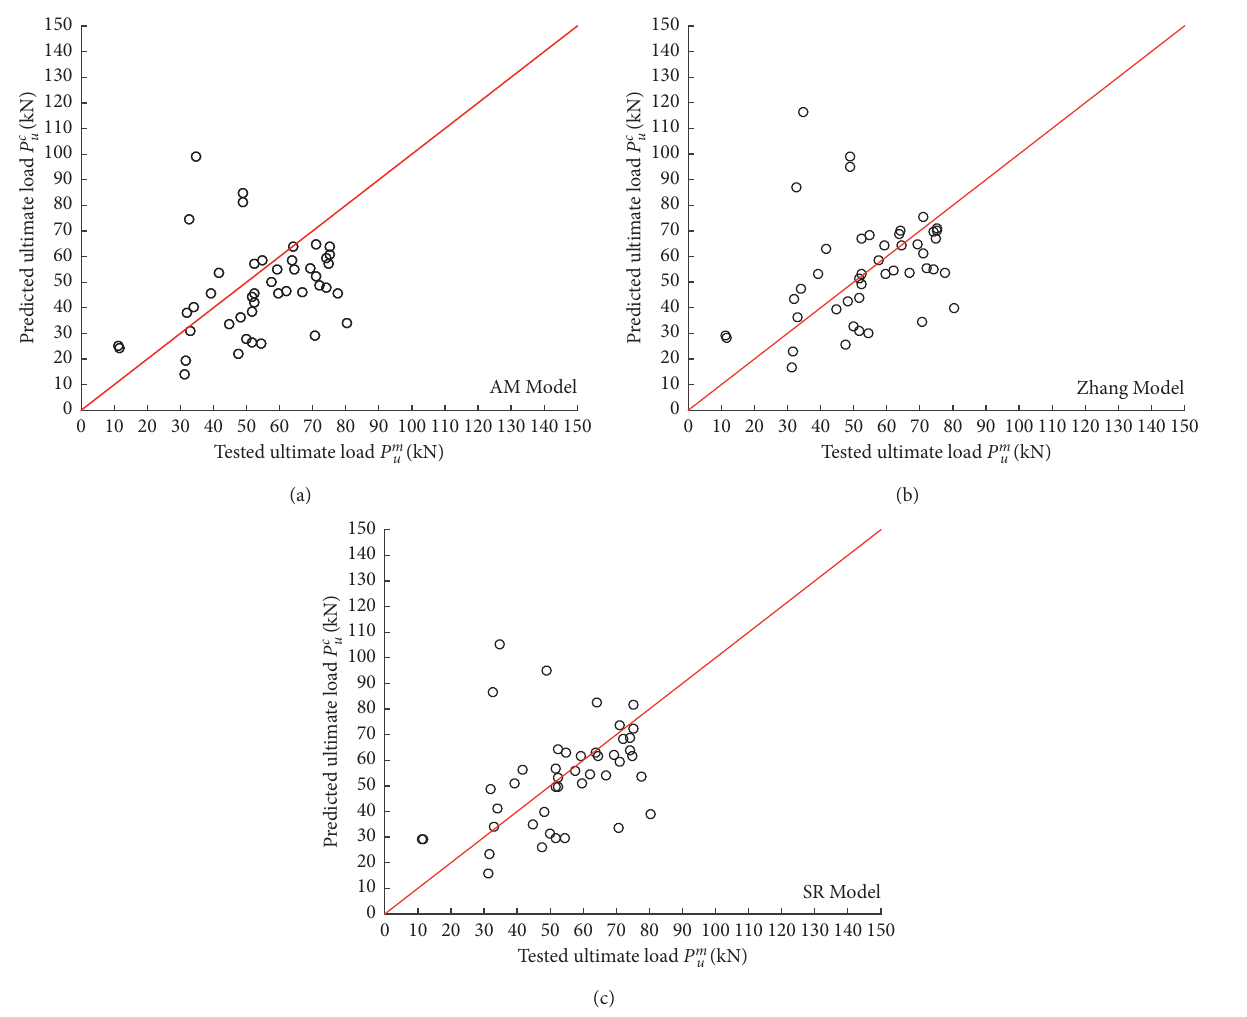
Figure 3: Comparison between the calculated value and the experimental value for the three models under the adhesive failure mode: (a) AM Model, (b) Zhang Model, and (c) SR